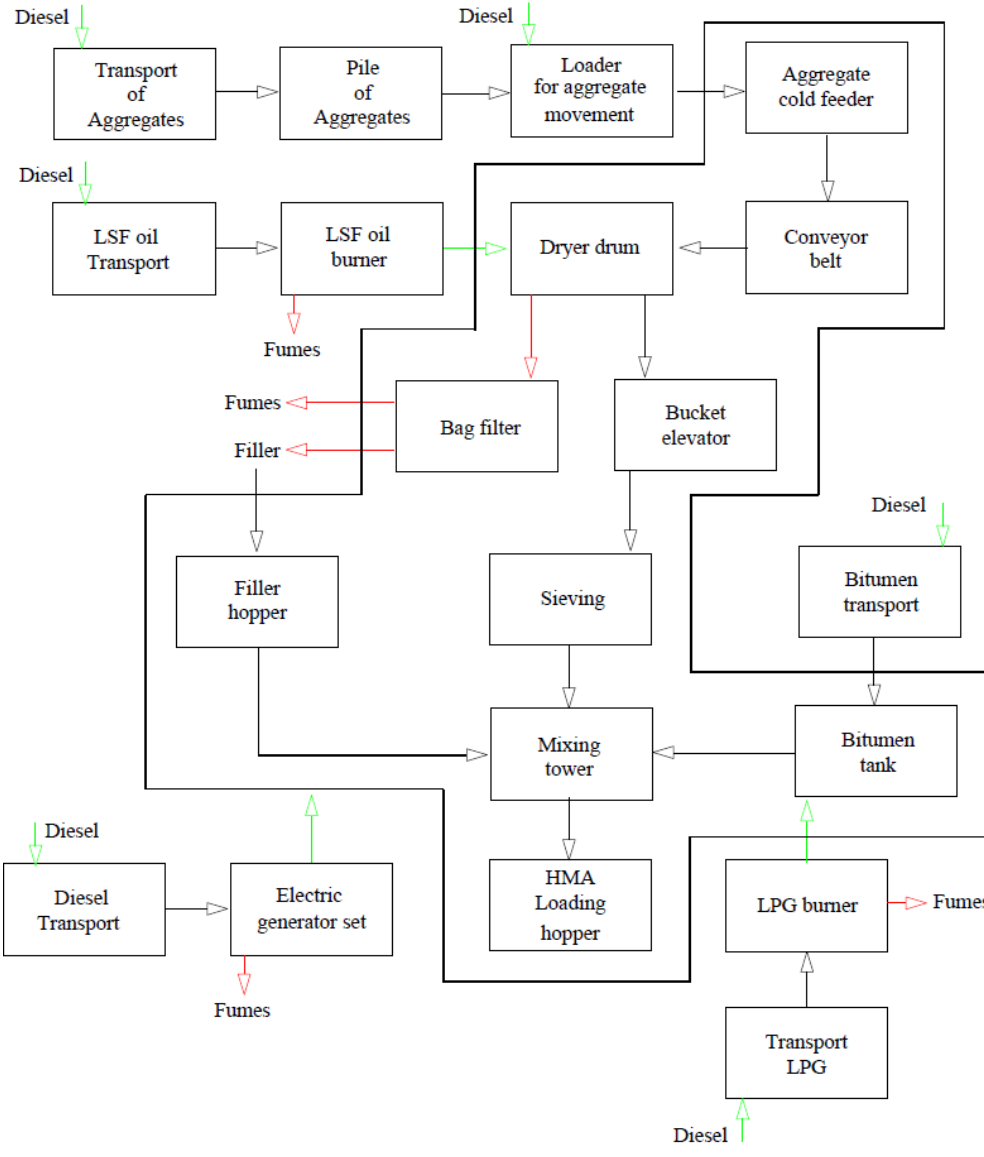
Figure 1. Reference scheme of the considered processes.